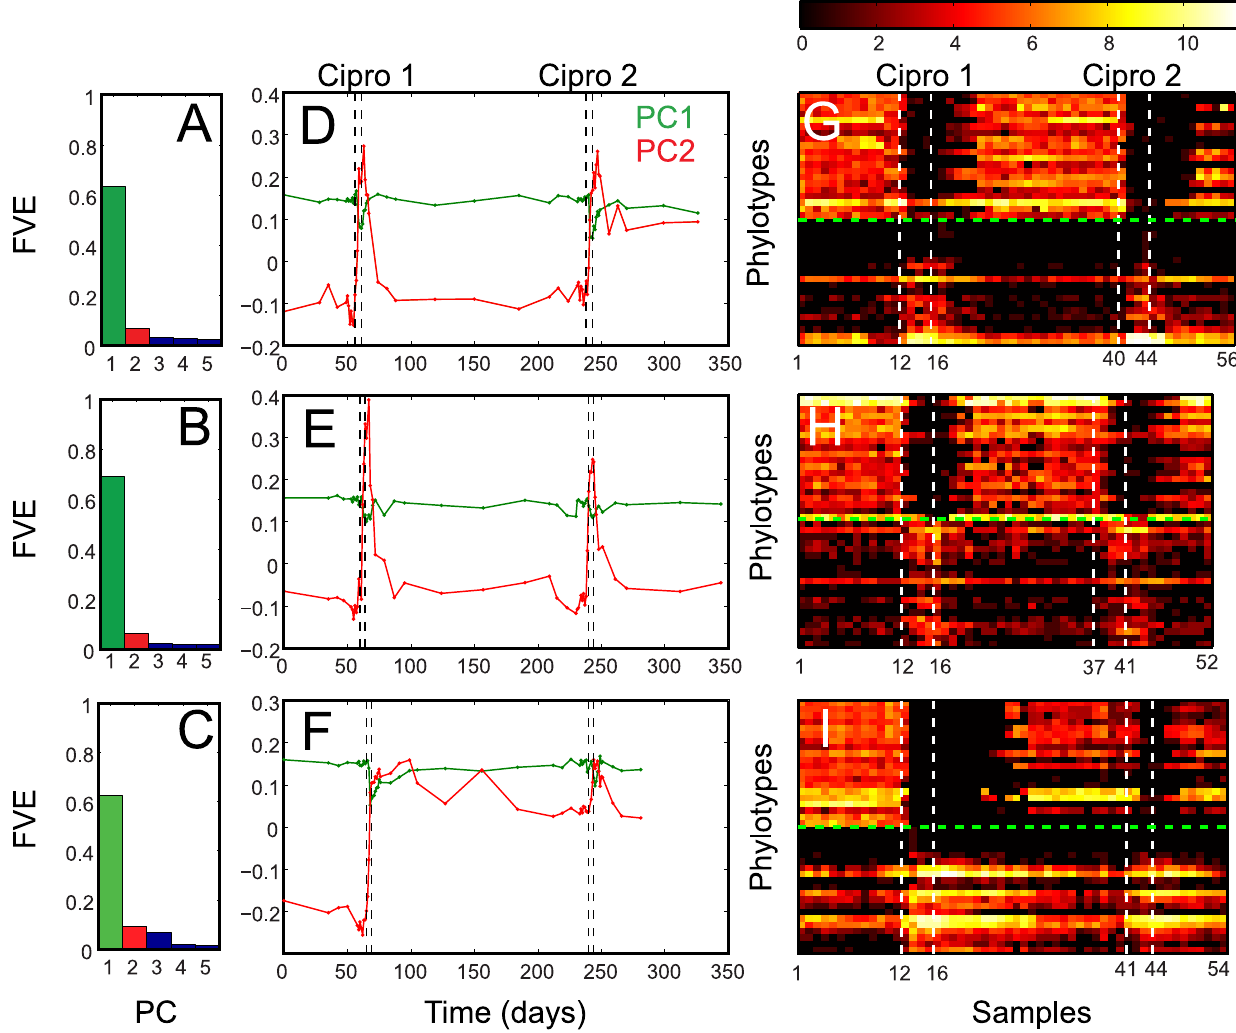
Figure 5. Analysis of microbiota response to the antibiotic ciprofloxacin from three subjects [ 24 ] using singular value decomposition identifies antibiotic-sensitive and antibiotic-tolerant bacteria. A–C: fraction of variance explained by the five most dominant components. D–F: plot of each sample component 1 (green) and 2 (red) coordinates versus sample time. G–I: sorting of the phylotypes log2-transformed abundance matrix based on the correlation within the two principal component. Above (below) the green dashed lines, we display the time series of the top 20 phylotypes strongly correlated (anti-correlated) with component 1 and anti-correlated (correlated) with 2 and dropping (increasing) during treatment, which we identify as sensitves (tolerants). Subject 3 (C,F,I) displays absence of sensitive bacteria for a prolonged period of about 50 days after the first antibiotic treatment. This confirms the fact that microbiota response to antibiotic can differ from subject to subject. Additionally, it also supports our model prediction of remaining locked in a tolerant-dominated state after antibiotic treatment